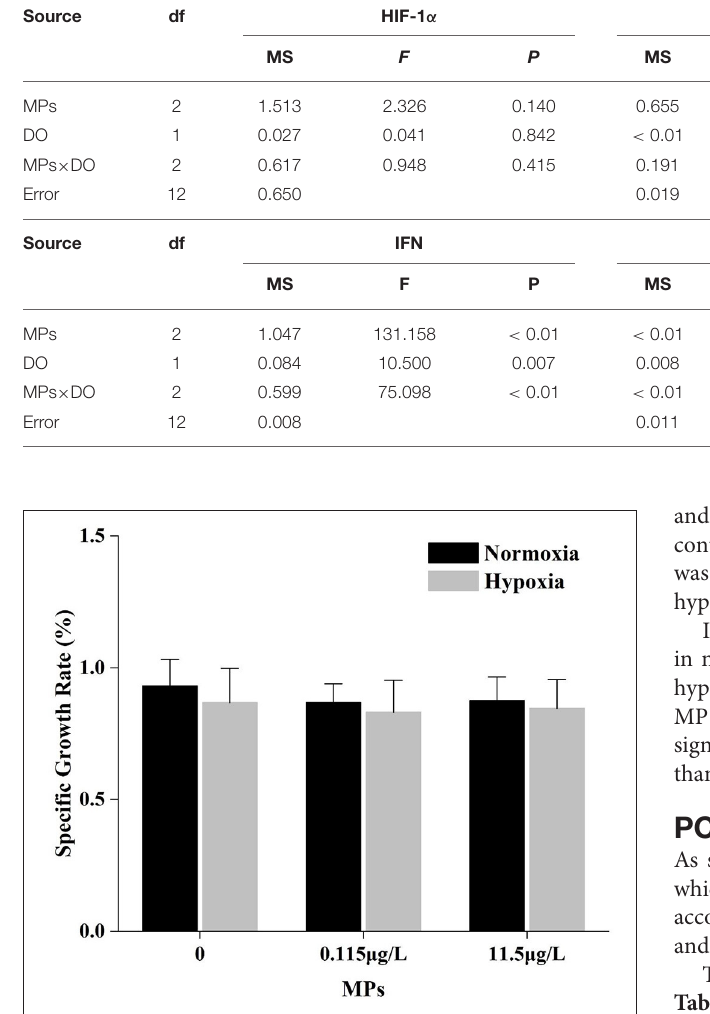
TABLE 2 | Summary of two-way ANOVA results on effects of microplastics (MPs) and dissolved oxygen (DO) on SGR, HIF-1 α , TNF- α , IL-8, and IFN of Pelteobagrus fulvidraco . Source